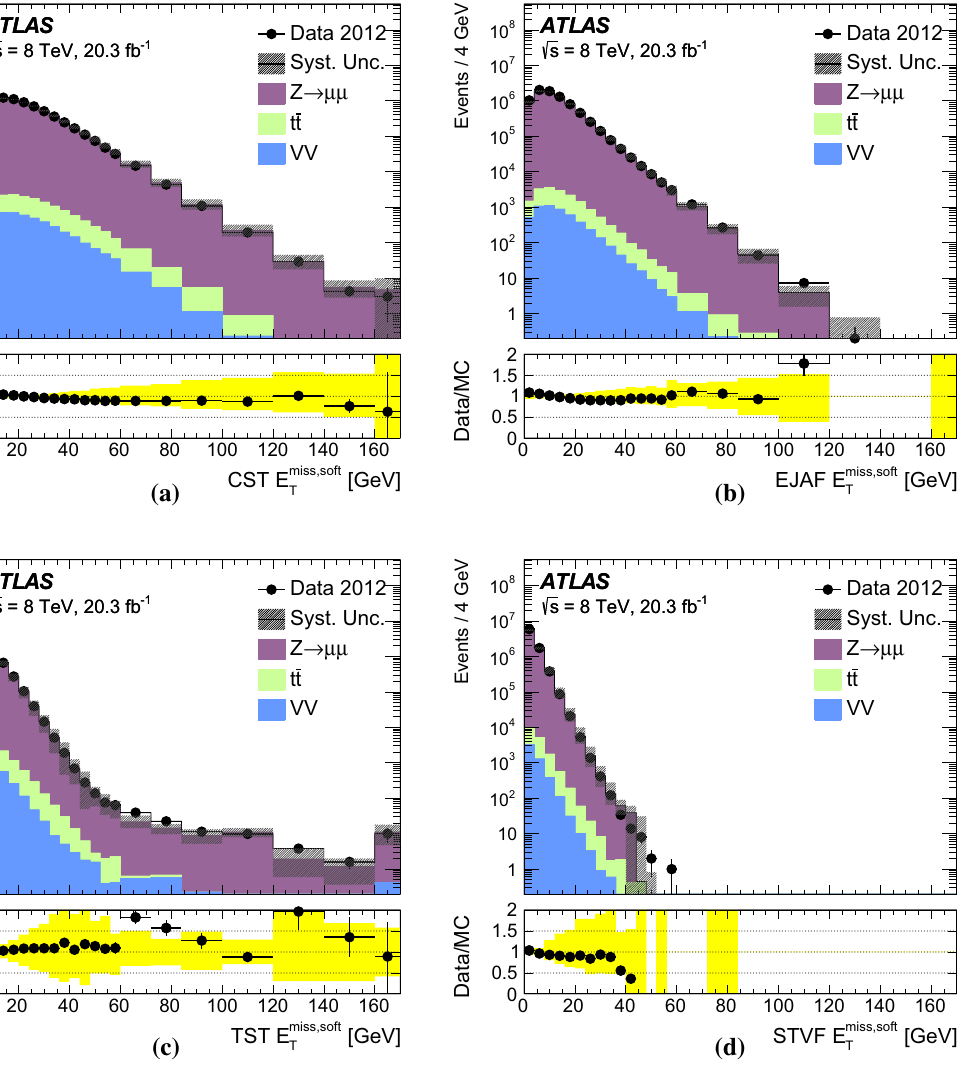
Fig. 4 Distributions of the soft term for the a CST, b EJAF, c TST, and d STVF are shown in data and MC simulation events satisfying the Z → μμ selection. The lower panel of the figures show the ratio